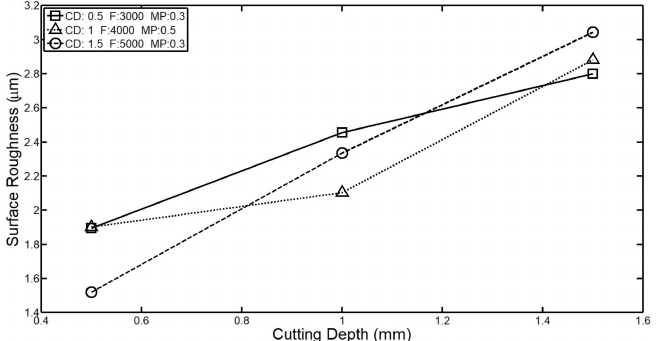
Figure 3. The influence of cutting depth on surface roughness.